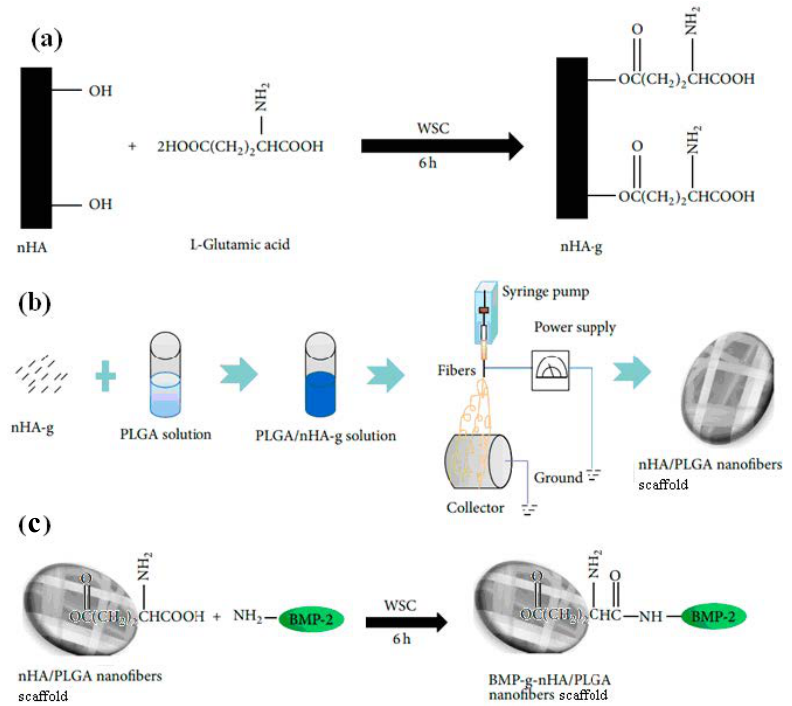
Figure 20. Schematic representation of BMP-2 grafting at the surface of nHA/PLGA nanofiber scaffolds. ( a ) L-glutamic acid modified nHA; ( b ) nHA filled PLGA scaffold; ( c ) BMP-2 modified PLGA scaffolds [21].